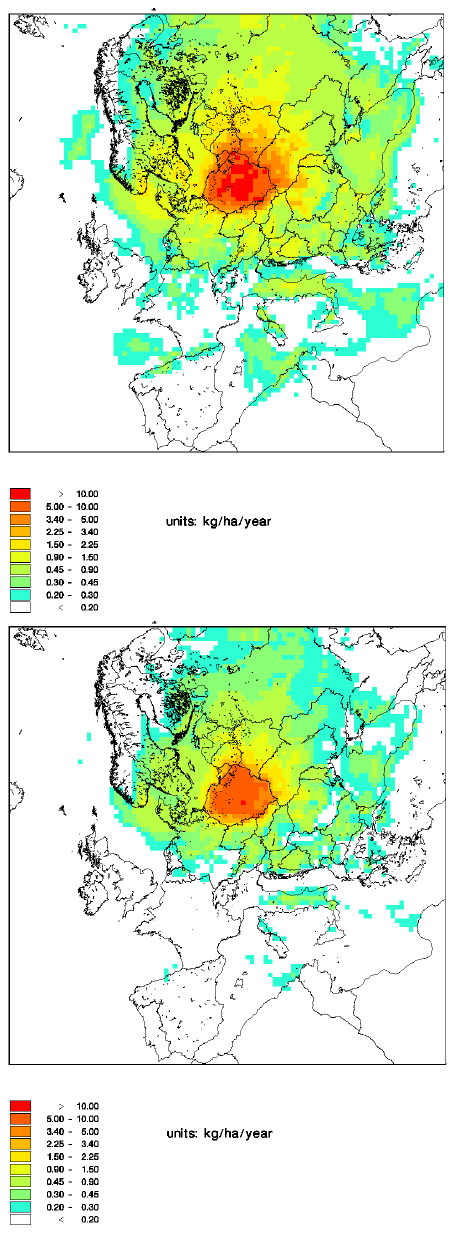
Fig. 4. Simulated annual deposition of nitrogen across Europe, based on emissions from present day sources in Poland (top) and 2020 sources in Poland (bottom), using the tagging method. The common unit for nitrogen deposition [kgNha − 1 ] is used. Multiply with 100 to convert to [kgNkm − 2 ].